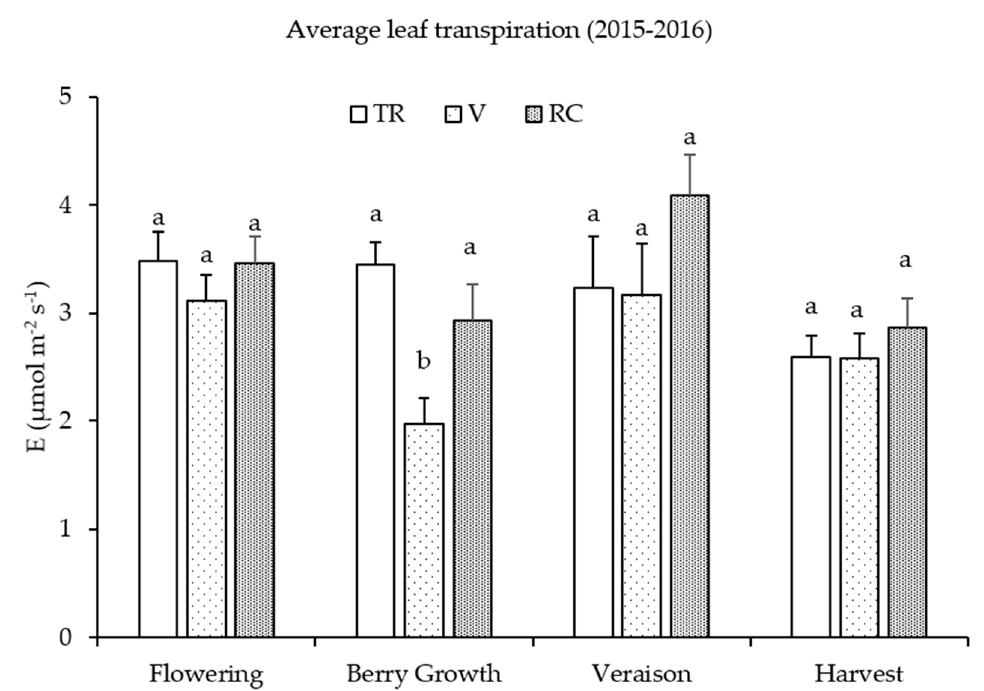
Figure 2. Soil management effects on leaf transpiration. (Different letters indicate statistical difference at p < 0.05; error bars indicate the standard error; n. of rep. 9). Note. TR = subterranean clover; V = common vetch; RC = roller crimper vetch.